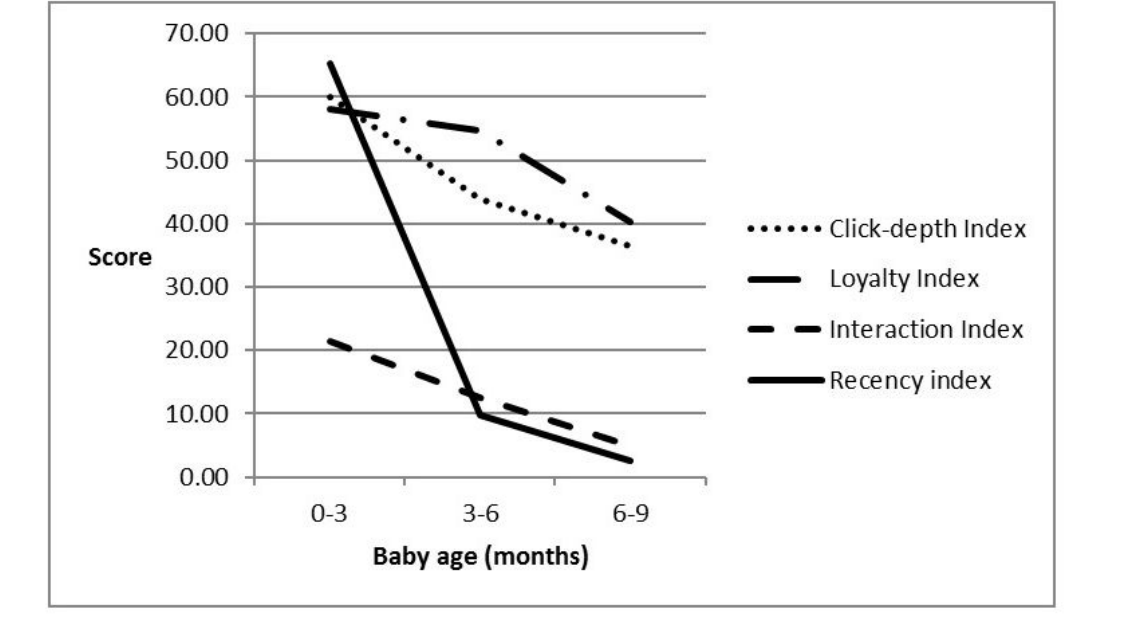
Figure 4. The frequency of scores for click-depth index (Ci), loyalty index (Li), interaction index (Ii), and recency index (Ri) at each time point (initial, interim, and